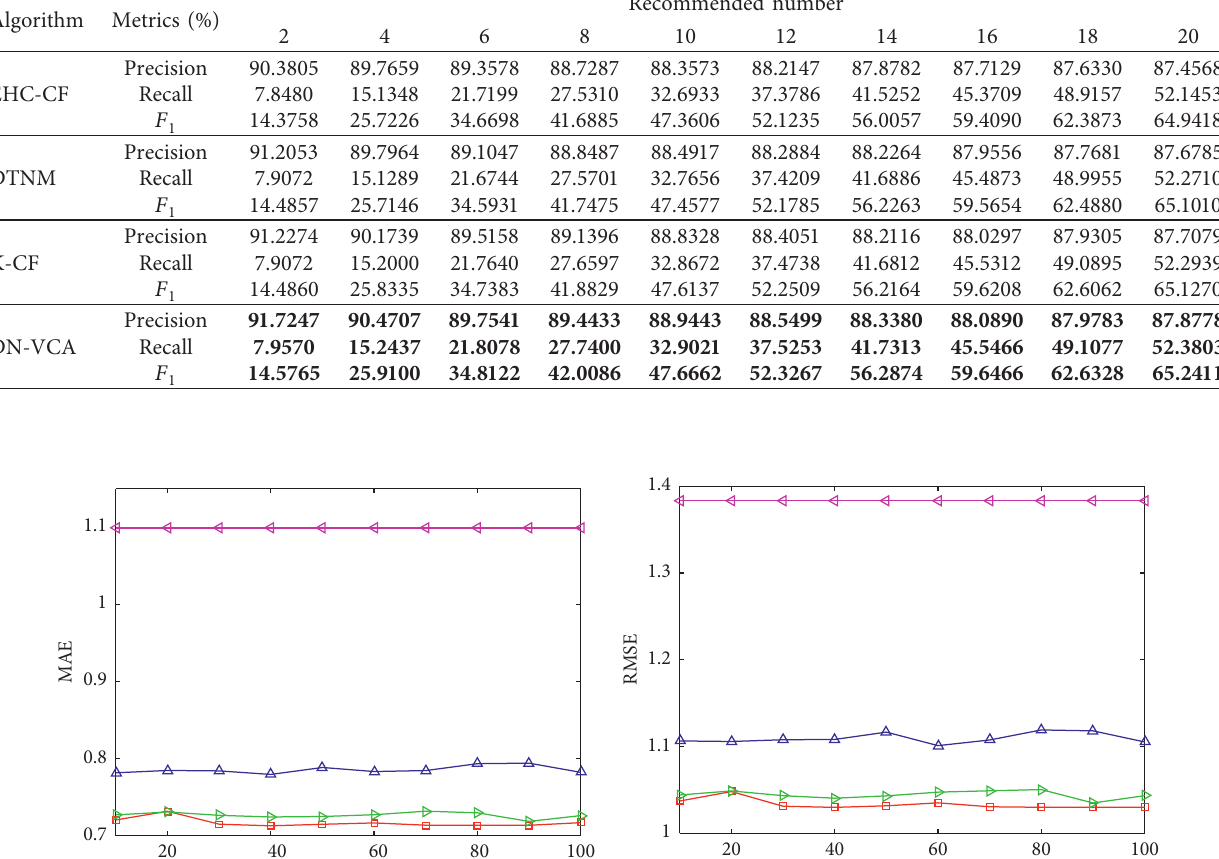
Table 3: Precision, recall, and F Algorithm